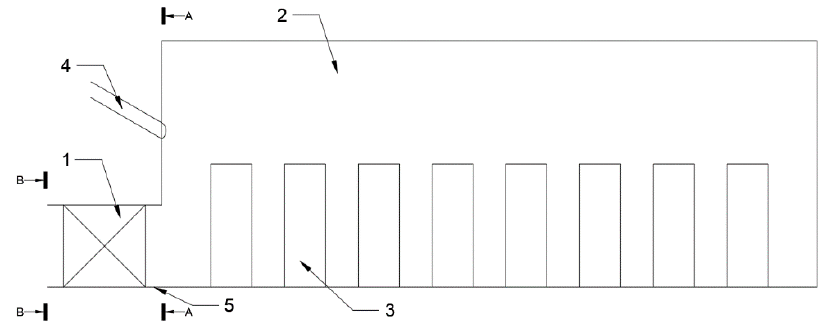
Figure 1. Scheme of a reheating furnace with regenerators and with distributed volumetric combustion: 1—regenerator; 2—working chamber; 3—heated material; 4—gas nozzle; 5—flue gas ducts.